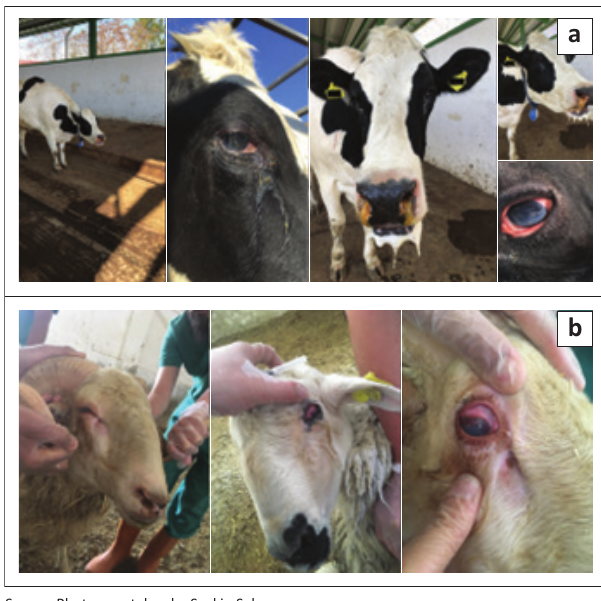
FIGURE 1: (a) Clinical signs of an affected cow; (b) clinical signs of affected